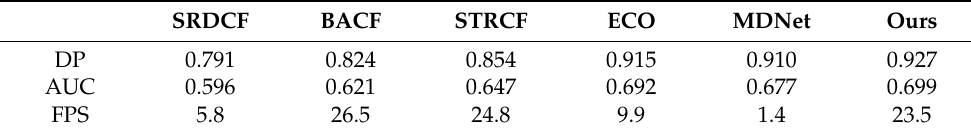
Table 1. The comparisons of precision, success rate and